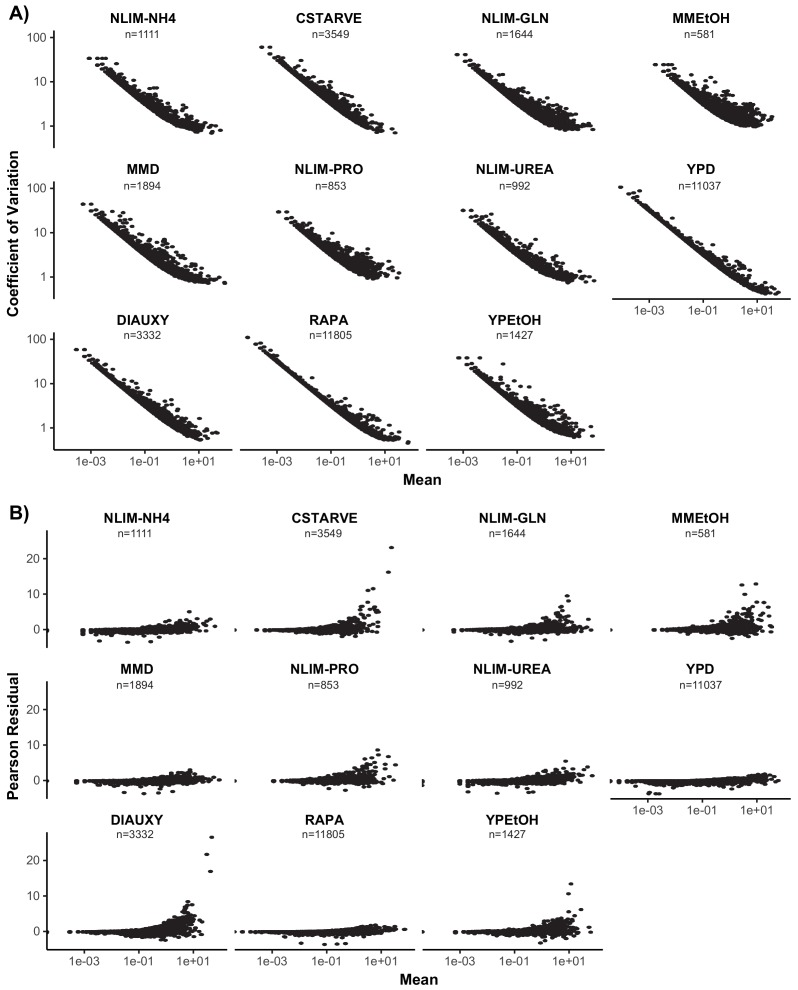
Measures of Gene Variance in Each Condition.(A) Coefficient of variation (standard deviation over mean) plotted against mean of each gene for each growth condition. Both axes are plotted on a log scale. (B) The mean pearson residuals (residuals over expected standard deviation) of a regularized negative binomial regression model calculated for each gene by the R package sctransform. The mean gene expression is plotted on a log scale.